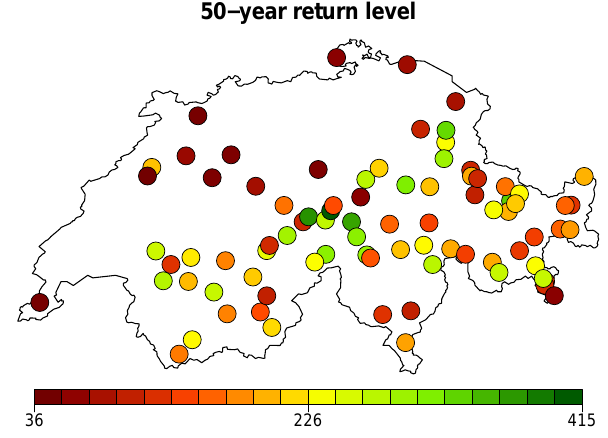
Fig. 4. Pointwise 50-year snow depth return level map (in centimeters).